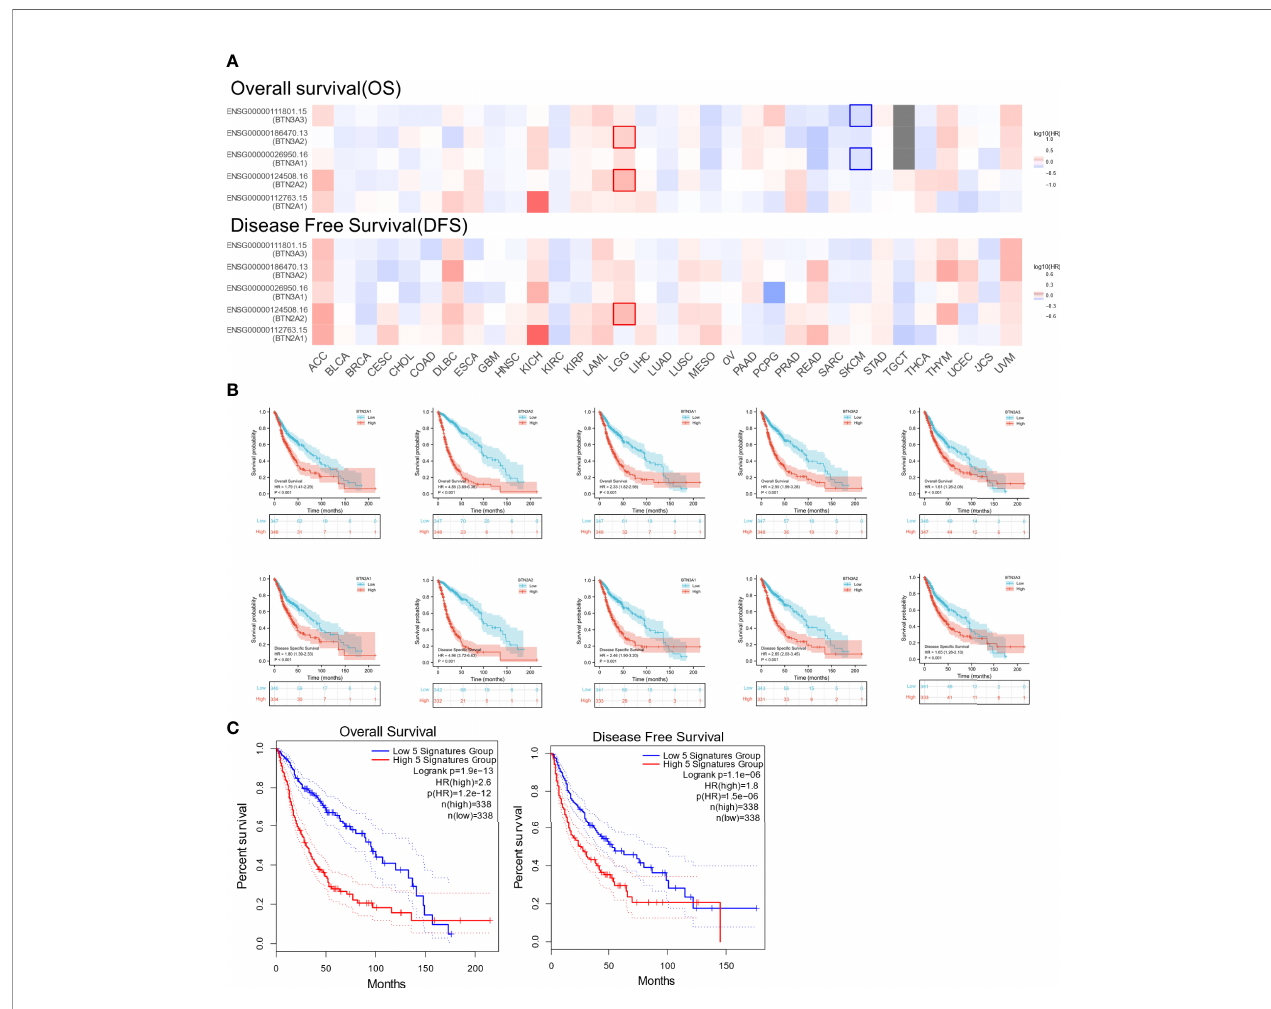
FIGURE 3 | The prognostic value of BTN2/3 subfamily members in pan-glioma. (A) Survival map of BTN2/3 subfamily members across 33 cancer types from TCGA. (B) Survival curves of BTN2/3 subfamily members were analyzed by R software. Top, overall survival (OS); bottom, disease-speci fi c survival (DSS). (C) Survival curves of BTN2/3 subfamily 5 gene signatures were analyzed by R software. TCGA, The Cancer Genome Atlas.